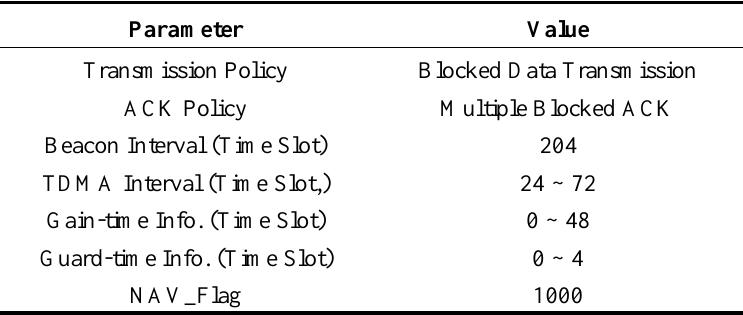
Table 5. Sample of UW-ASN system output